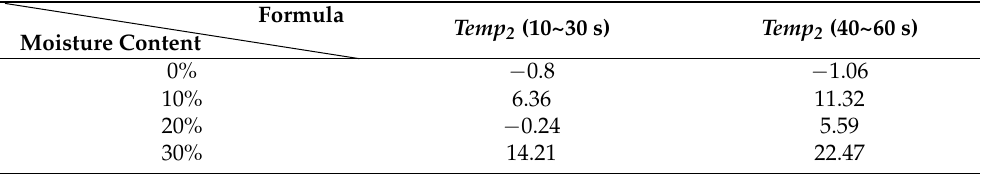
Table 5. Average difference in the soil internal